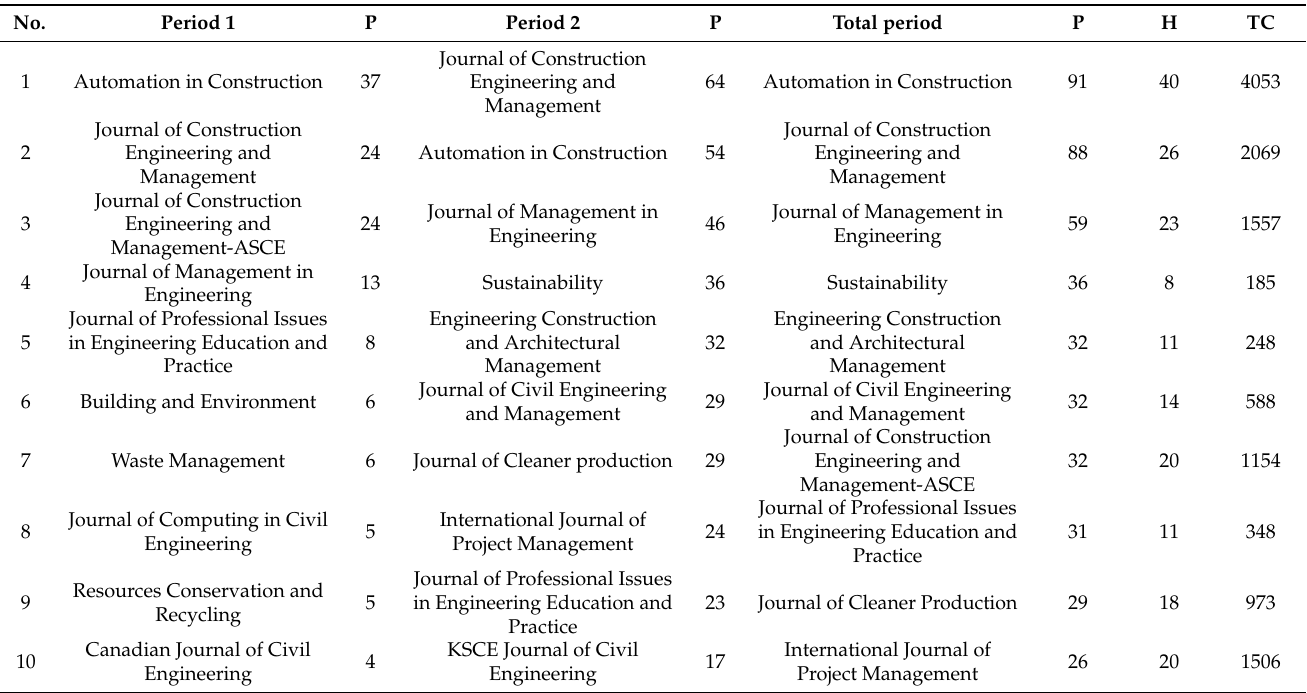
Table 2. Top 10 sources for the